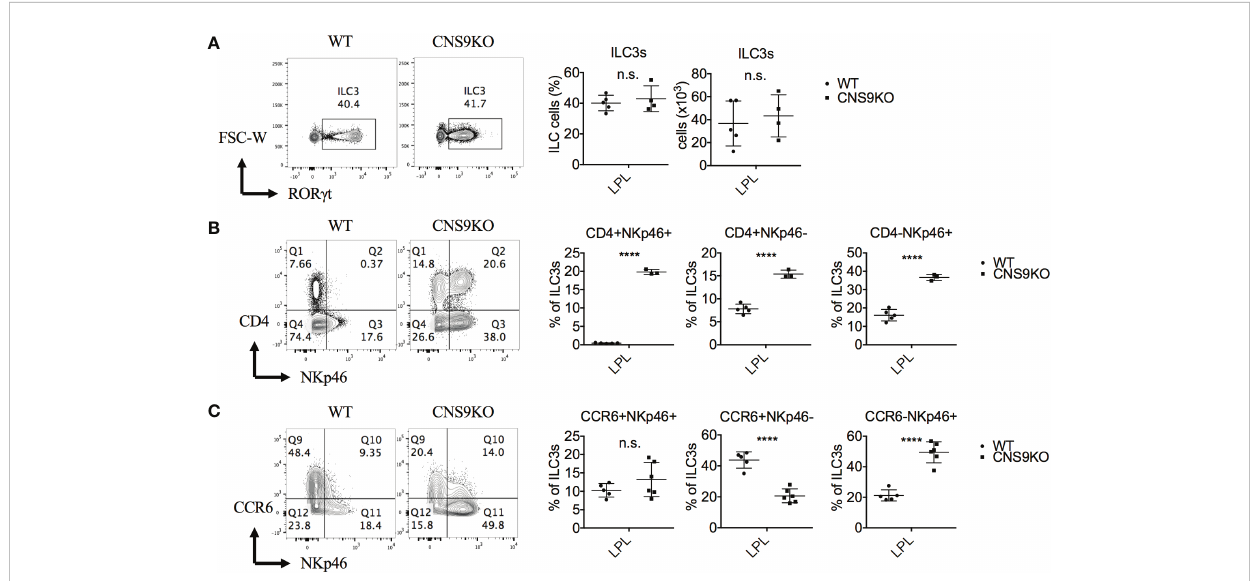
FIGURE 1 CNS9 de fi ciency alters the composition of ILC3s. ILC3s were isolated from the small intestine lamina propria lymphocytes (LPLs) of age- and sex- matched WT and CNS9-de fi cient (CNS9KO in fi gure) mice under steady state, directly stained with indicated surface markers and ROR g t, and then analyzed by fl ow cytometry. (A) Left: intracellular staining of ROR g t (pre-gated on Live CD45 + CD3 - CD90 + ); right: statistic of the staining data and cell number of ILC3s. Staining (left) and statistic (right) of the surface marker CD4 and NKp46 (B) or CD4 and CCR6 (C) on ILC3s (pre-gated on ILC3: Live CD45 + CD3 - CD90 + ROR g t + ). The data shown are a representative of two to three independent experiments and presented as mean ± SD. Also see Figure S1. Statistical signi fi cance was calculated using unpaired Student ’ s t test and shown as ****p < 0.0001 or n.s. (non-signi fi cant) p >